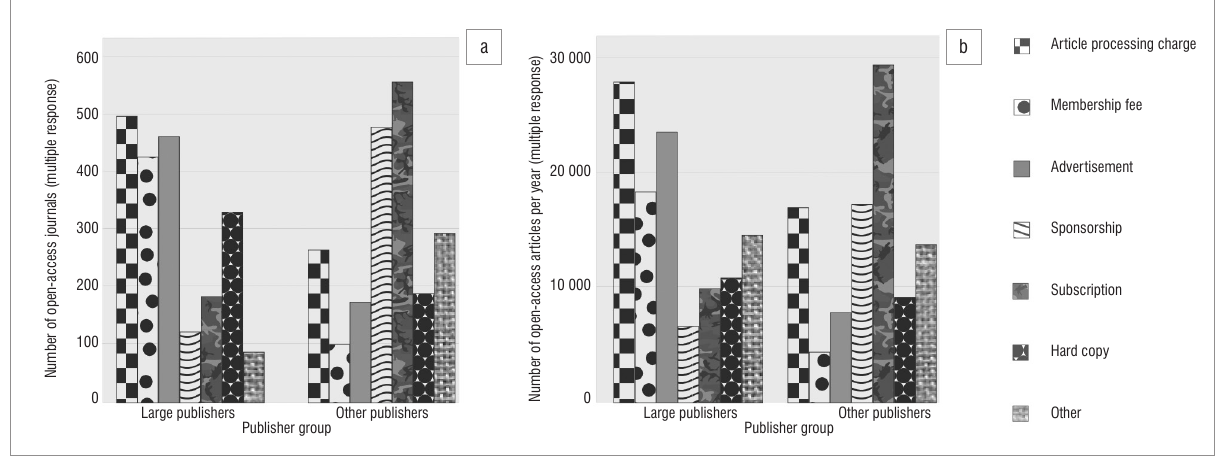
Figure 4: The number of (a) journals and (b) articles as a function of the income source of publishers, for large publishers and other publishers. ‘Large’